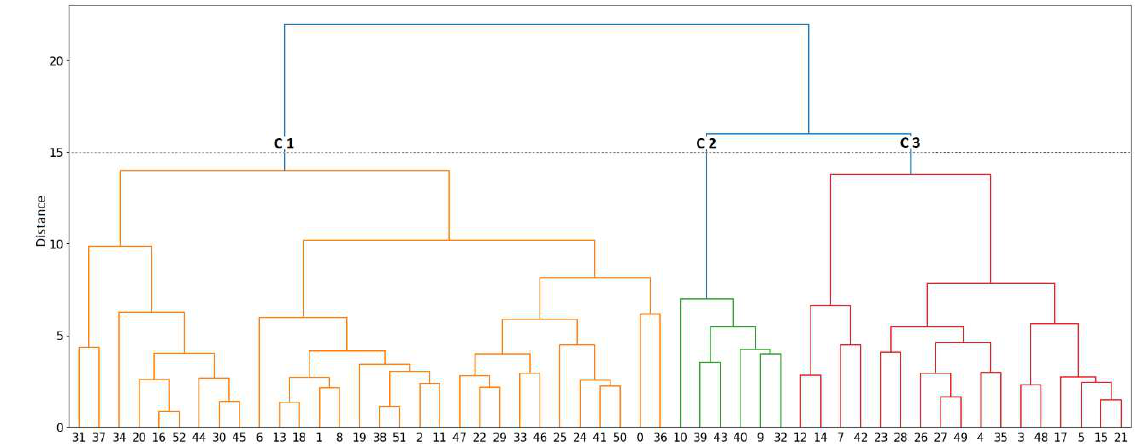
Figure 6. Cluster analysis dendrogram for 53 groundwater samples from the aquifer of La Yarada.